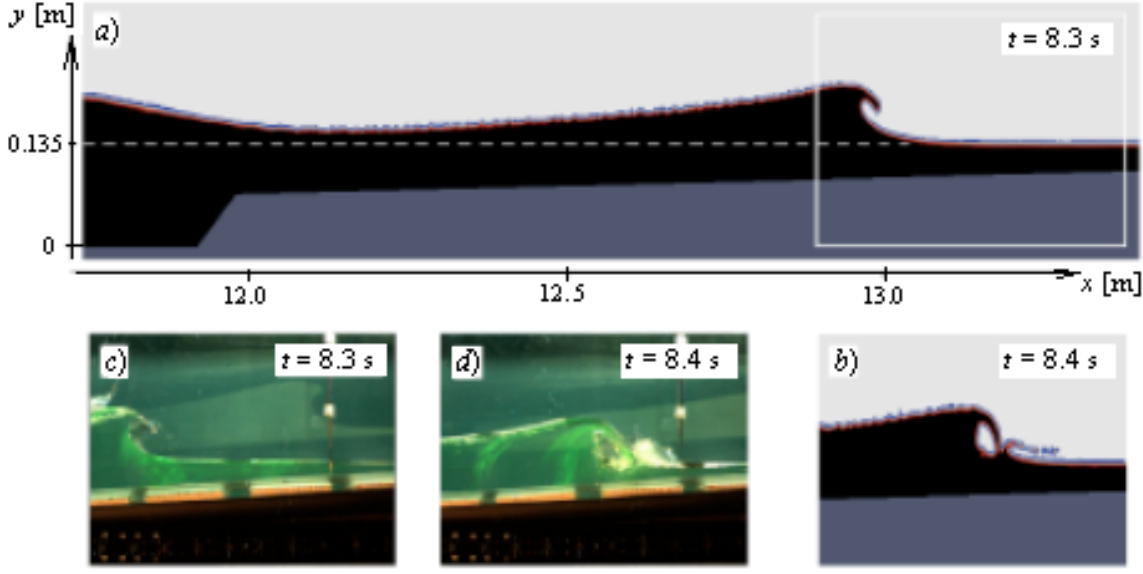
Figure 9. Breaking of wave interacting with shallow water. The comparison of experimental results with numerical simulation at H = 0.135 m, A/H = 0.61, H sh = 0.054 m, A / H sh = 1.52: ( a , c )— t = 8.3 s; ( b , d )— t = 8.4 s.